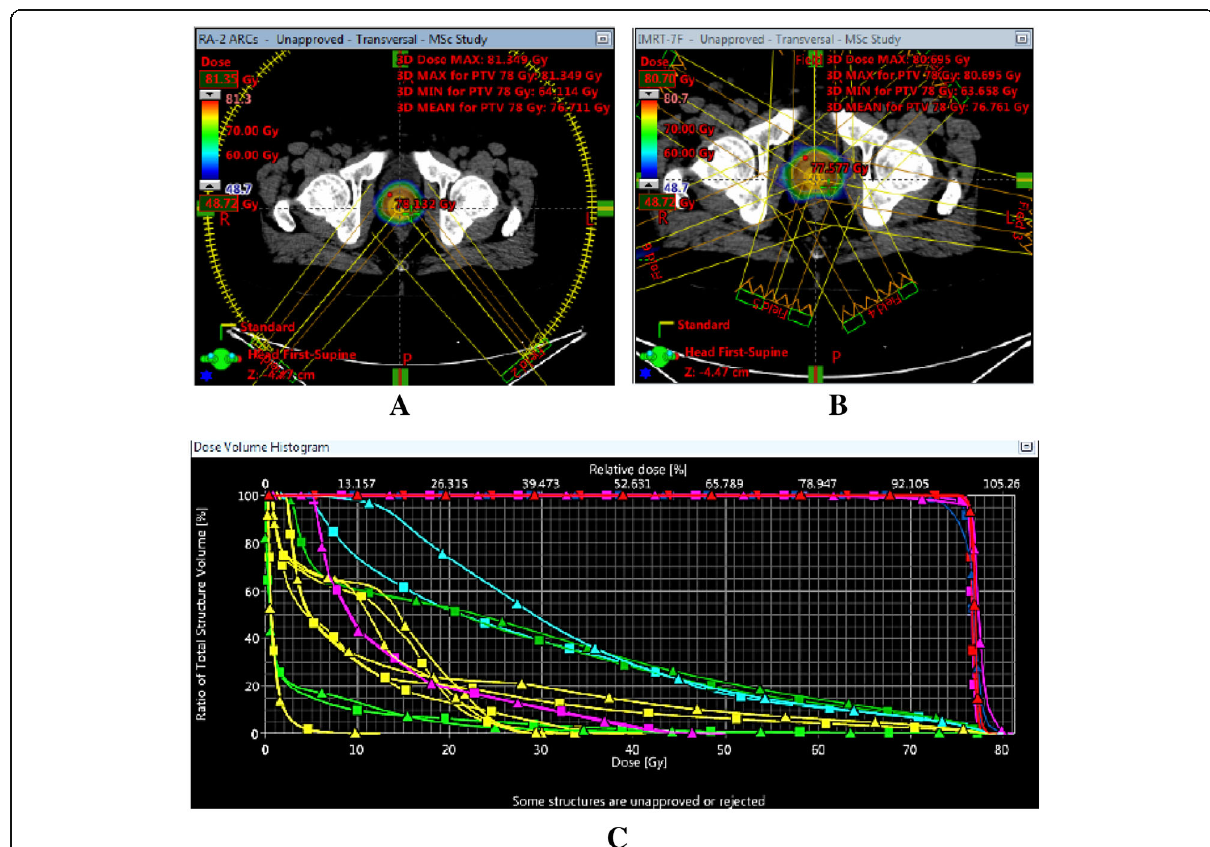
Fig. 3 Both a RapidArc plan and b IMRT plan was evaluated according to c dose-volume histogram (DVH) comparison displaying all organs (PTV, rectum, bladder, Rt femoral head, and Lt femoral